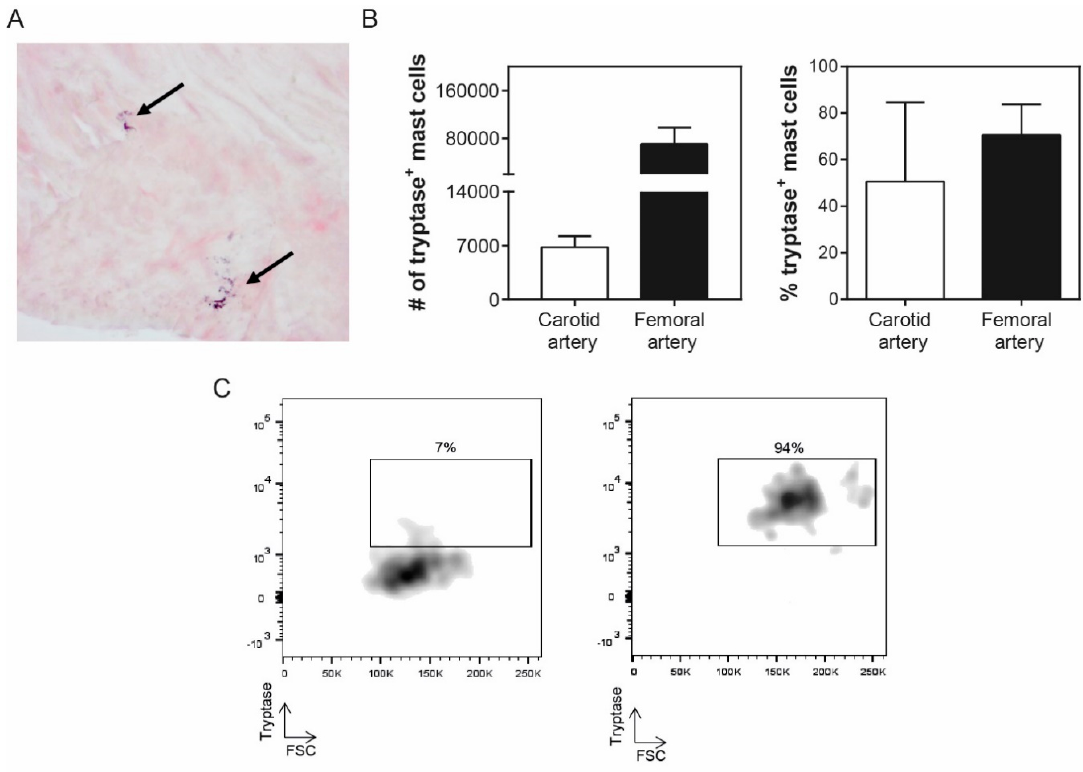
Figure 4. Tryptase content of mast cells in human atherosclerotic plaques. ( A ) Immunohistochemical tryptase staining of a human atherosclerotic plaque. Arrows indicate activated mast cells. ( B ) Number (left panel) and percentage (right panel) of mast cells containing tryptase in human carotid and femoral arteries based on flow cytometry. ( C ) Flow cytometry plot examples of tryptase + mast cells, that is, left panel: low tryptase expression (7% of the mast cell population) vs. right panel: high tryptase expression (94% of the mast cell population). Values are depicted as mean ± SEM.